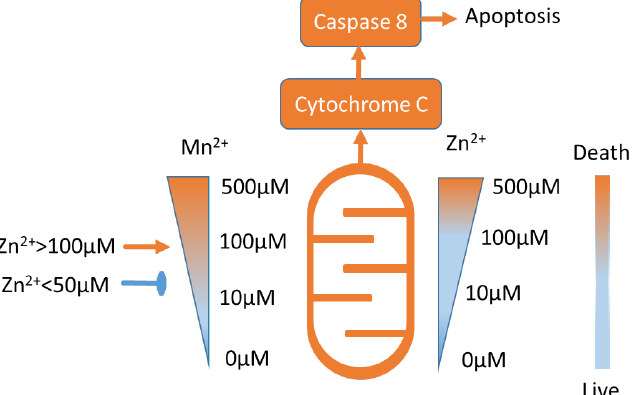
Figure 2. Approximate Mn 2 + and Zn 2+ toxicity ranges (see text for details). Low concentrations of Mn 2 + and Zn 2+ are not toxic. Notably, Zn 2+ in concentrations lower than 50 um inhibits Mn 2+